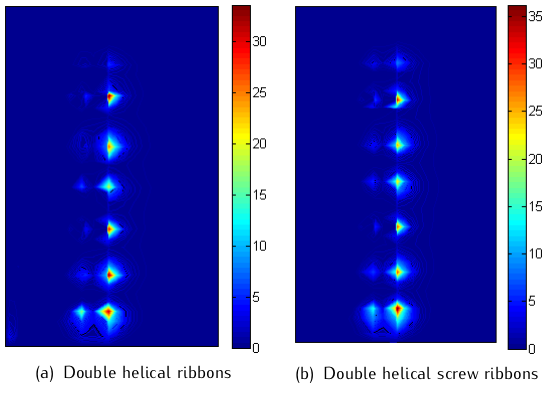
Figure 12. Dissipation rate induced in r-